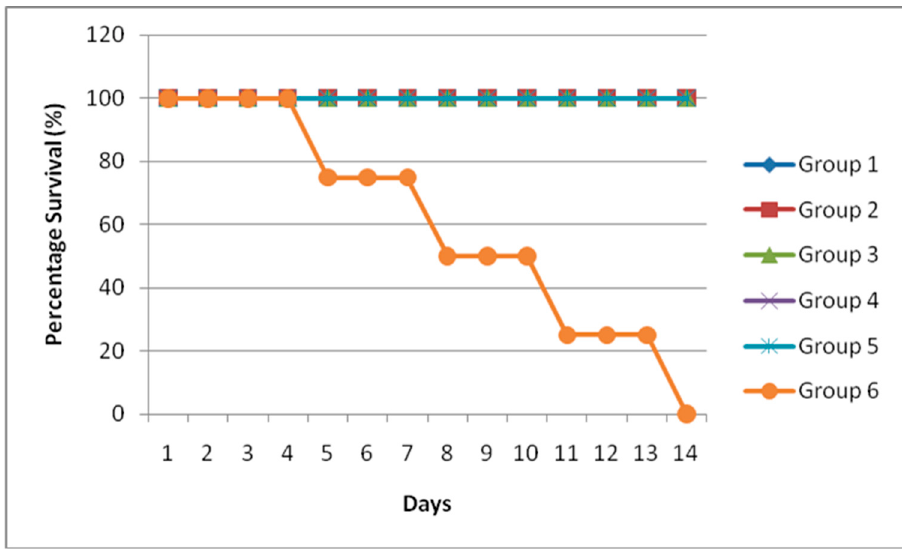
Figure 4. Percentage of survival of the experimental animals within 14 days.